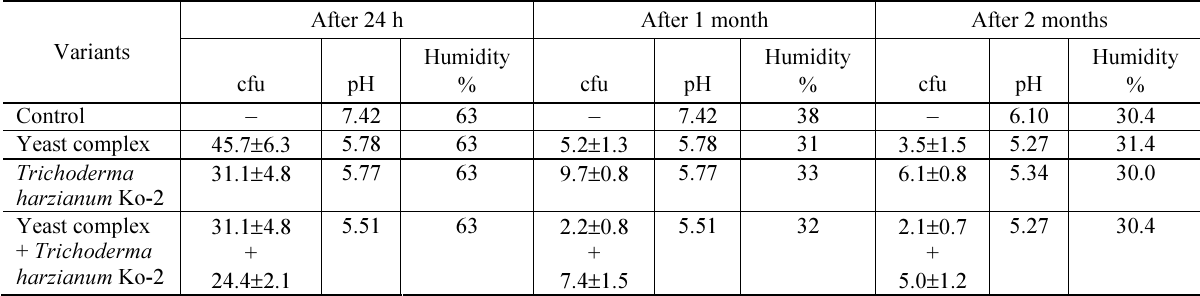
Table 5. The changes of introduced microorganism number cfu g mixture (1:20)